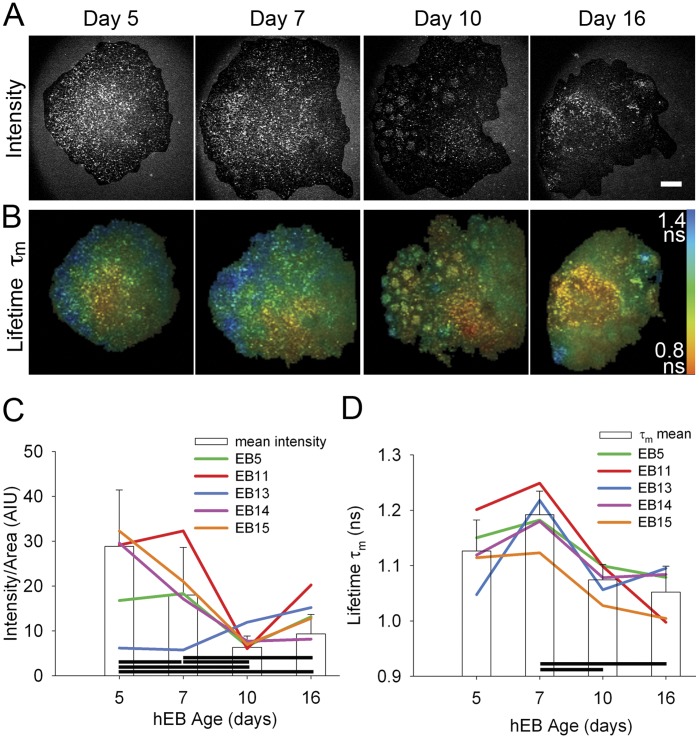
Global endogenous fluorescence intensity and lifetime changes observed with differentiation of human EBs.A. Background subtracted intensity of MPLSM single optical sections of the same live hEB at 5, 7, 10 and 16 days post-EB formation, using 780 nm excitation. B. Color mapped fluorescence lifetime (τm) of the same hEB as in upper row, over time. Color bar indicates lifetime values for τm. Scale bar = 50 µm. C. Quantitation shows changes in mean fluorescence intensity at the different time points (bars: for days 5, 7, 10, 16 n = 16, 17, 17, 16 EBs, respectively) while colored lines indicate the changes in intensity of individual EBs tracked over time. D. Quantitation of τm, with bar graph showing the mean τm at the given time points (for days 5, 7, 10, 16 n = 5, 6, 6, 5 EBs, respectively), while colored lines show the changes in lifetime of individual hEBs tracked over time. Horizontal bars indicate differences at P<0.05 (Holm-Sidak method for pairwise comparisons following repeated measures ANOVA). Quantitation of additional lifetime parameters and detailed statistics in Figure S6.